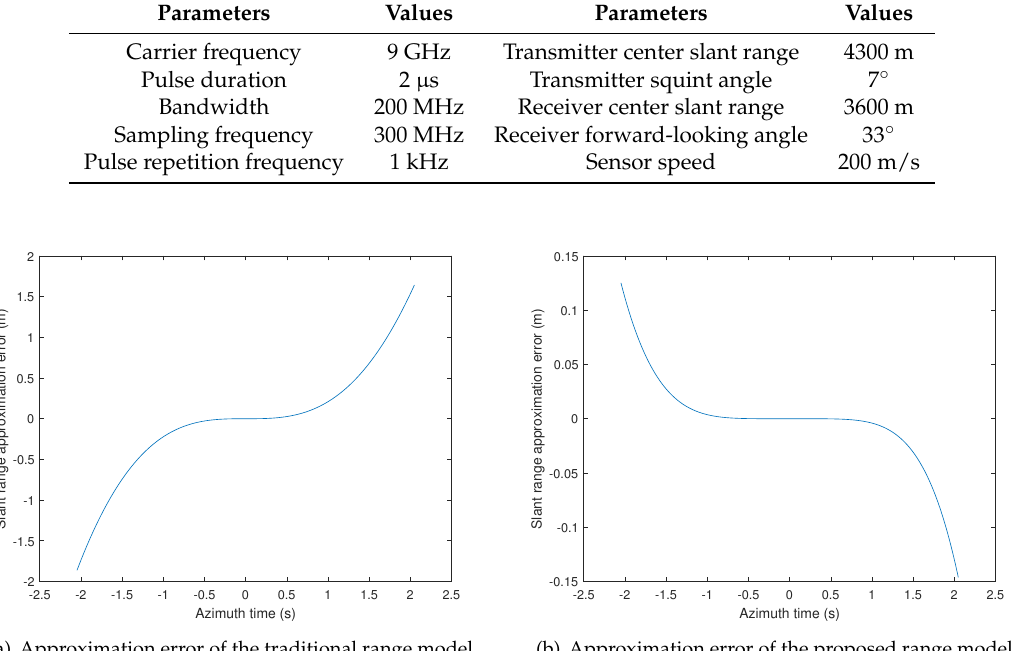
Figure 2. Approximation error of the bistatic slant range. ( a ) Approximation error of the traditional range model. ( b ) Approximation error of the proposed range